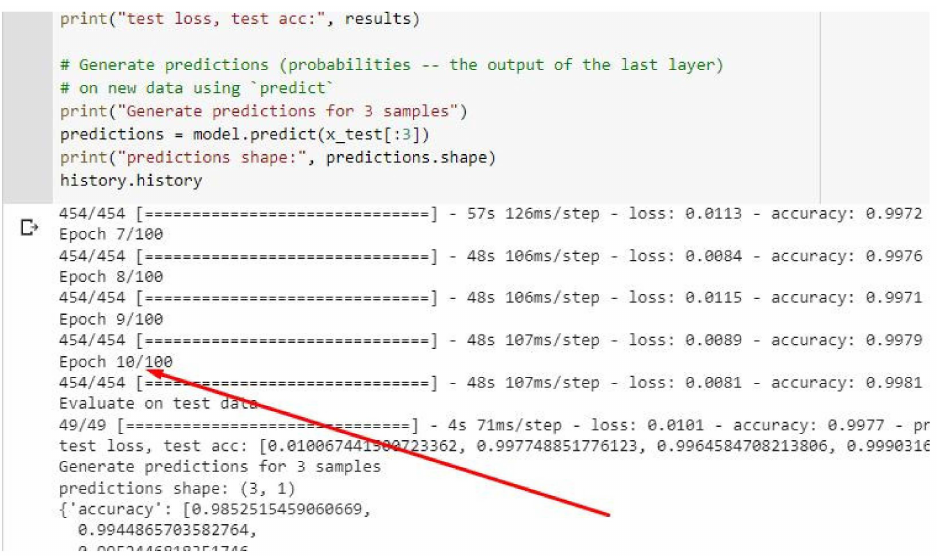
Figure 10. The epochs number of our proposed method.